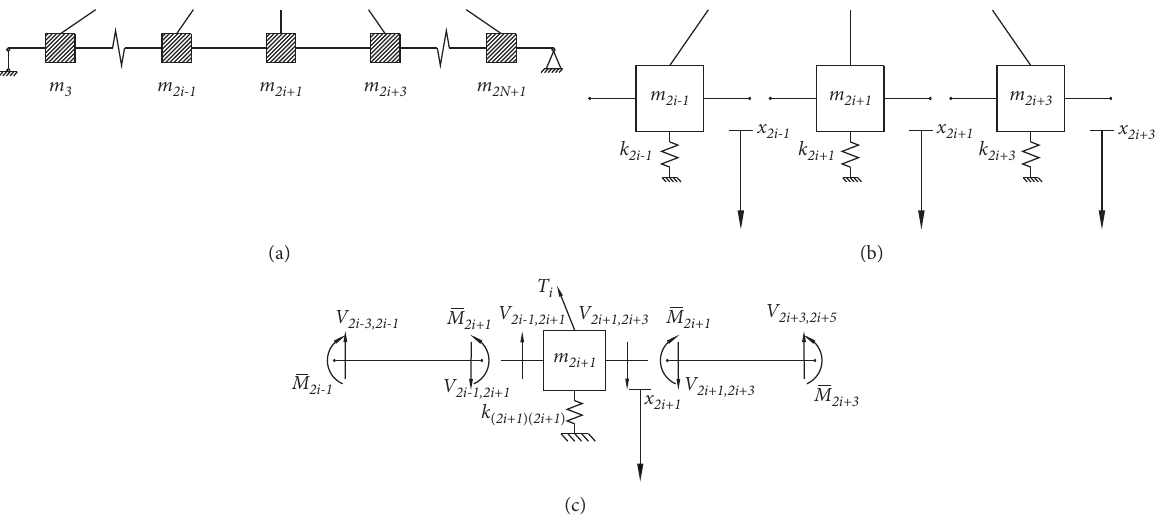
Figure 5: The beam portion model of i th subsystem and its adjacent beam portions. (a) Different simplified beam portions in a single beam. (b) The i th simplified subsystem and its adjacent beam portions. (c) The mechanical system of the beam portion in i th subsystem.